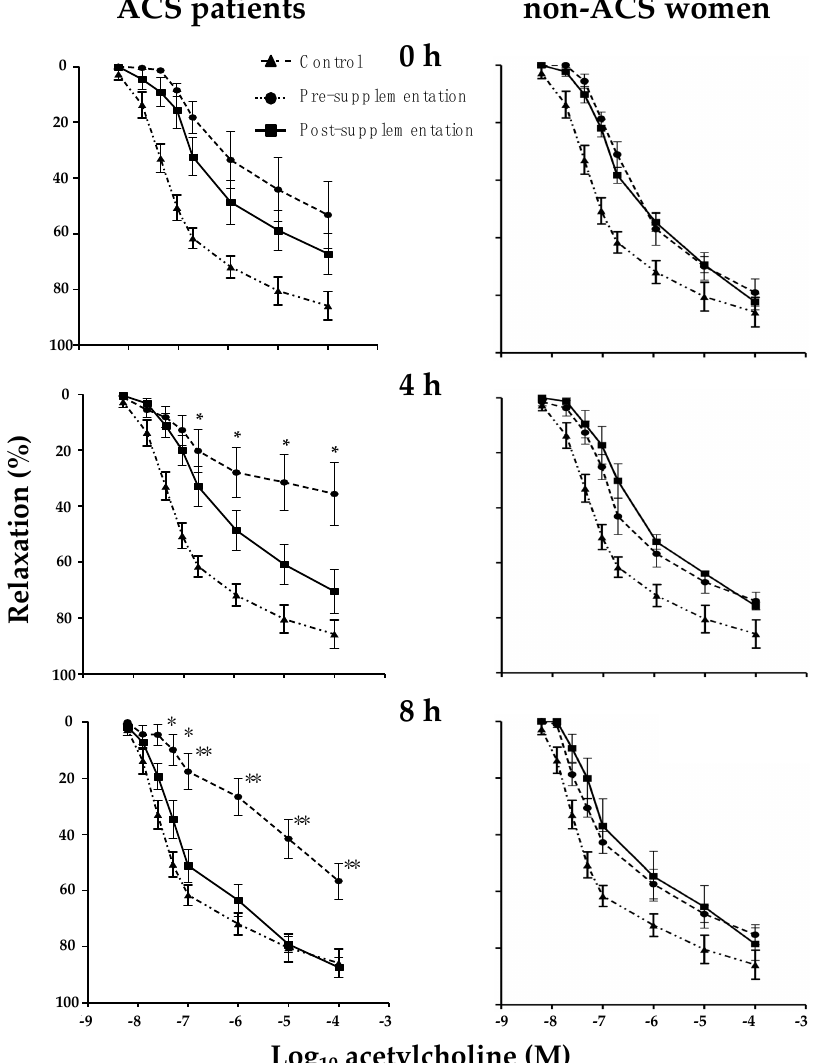
Figure 2. Effects of MiPo on endothelial-dependent relaxation of rat aortic rings incubated with high-density lipoproteins (HDL) from ACS patients ( n = 11) and the reference group of non-ACS women ( n = 6). Curves represent the % of relaxation of aorta rings, pre-contracted with phenylephrine and incubated with HDL, from before (black circles) and after 30 days of supplementation with MiPo (black squares) in function of the logarithm of acetylcholine concentration. Fasting conditions, and 4 h and 8 h after the lipid load test, are shown in the top, middle and bottom graphs, respectively. Each point represents the mean and standard error of the mean (SEM). A curve of 11 independent experiments using aorta rings incubated in the absence of HDL has been included in every graph (black triangles). Pre- and post-supplementation paired Student t test, * p ≤ 0.05 and ** p ≤